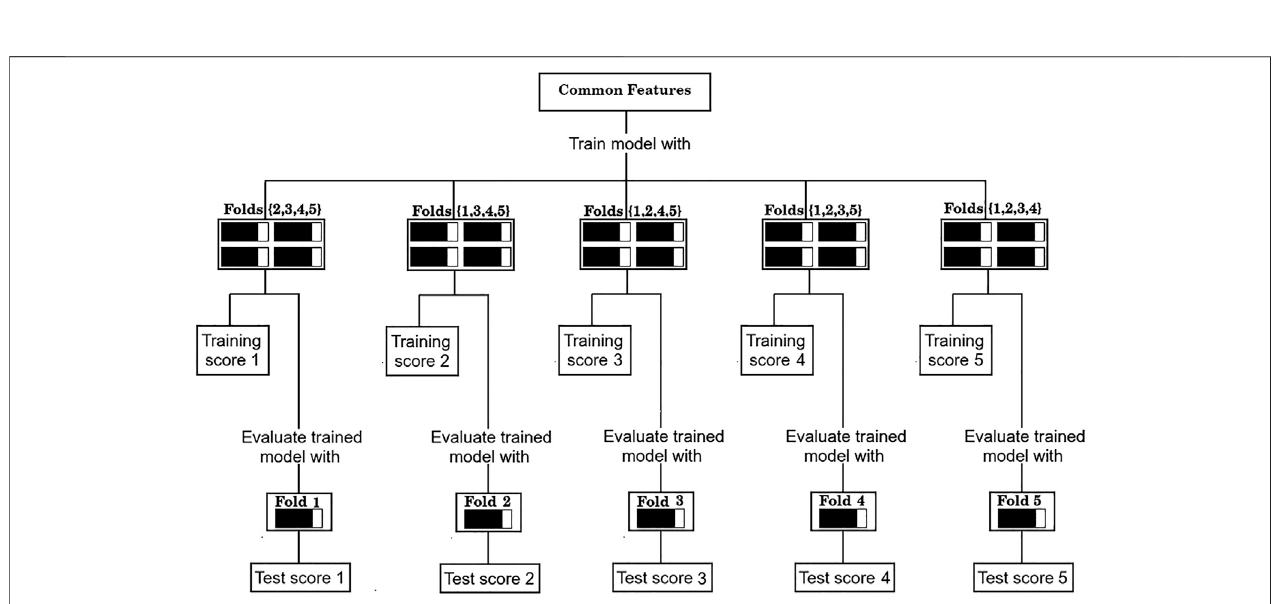
FIGURE 3 | Evaluation procedure of the common sets of features with the 5-fold cross validation scheme.